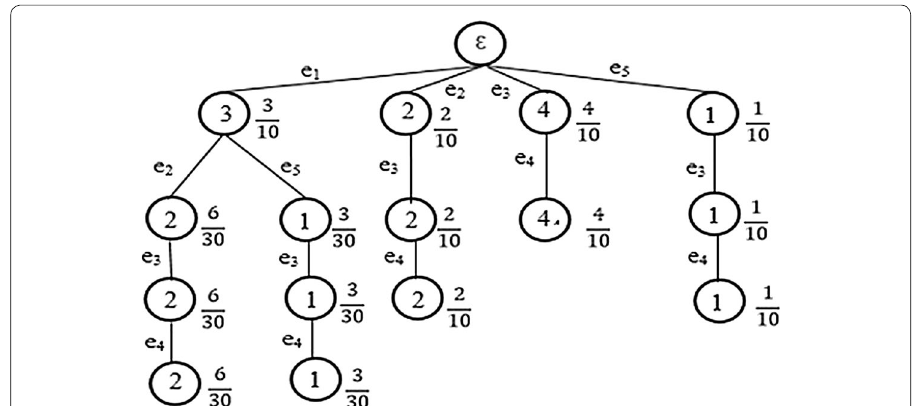
Fig. 7 Suffix tree with probability distribution with respect to root node of